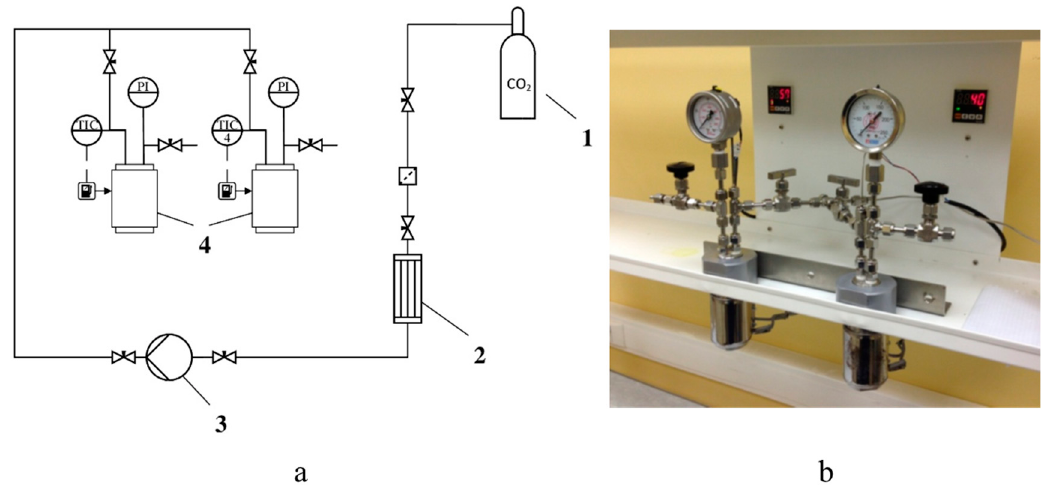
Figure 1. Scheme of the equipment for supercritical adsorption ( a ) and its outer look ( b ): 1–CO 2 tank, 2–heat exchanger, 3–liquid high-pressure pump, 4–high pressure reactors with heating jacket, PI-manometers, and TIC-temperature controller with operator panel.